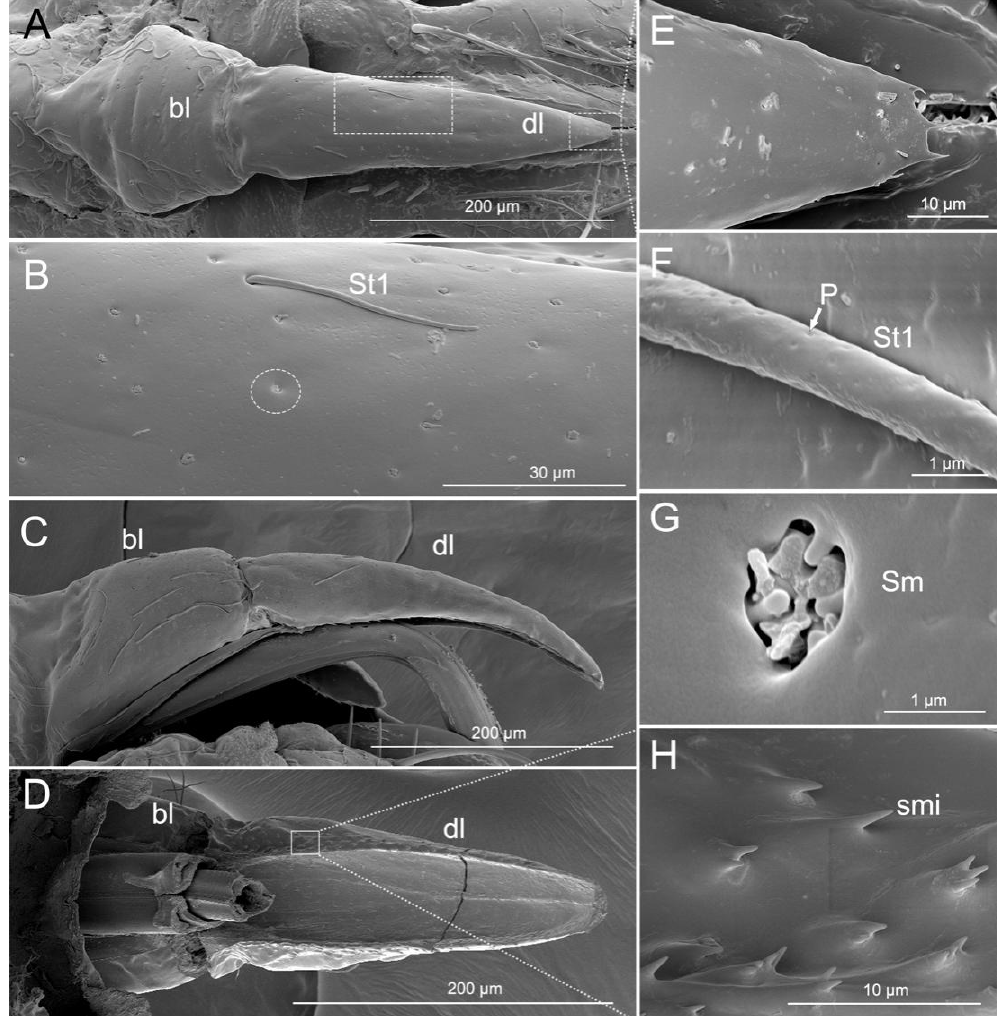
Figure 2. SEM of labrum of Haematoloecha nigrorufa. A . Ventral view; B. Enlarged view of box in ( A ), showing sensilla trichodea (St1) and multilobular sensilla (Sm); C . Lateral view; D . Dorsal view; E . Enlarged view of tip of labrum; F . Enlarged view of surface of sensilla trichodea (St1) showing pores ( p ); G . Enlarged view of multilobular sensilla (Sm); H . Enlarged view of box in (D ), showing spike-like microtrichia (smi); bl, basilabrum; dl, distilabrum.